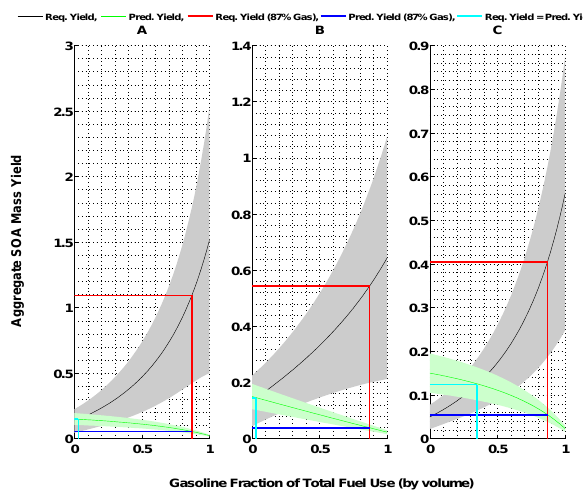
Gasoline Fraction of Total Fuel Use (by volume) Fig. 3. Vehicular SOA mass yields compared to ambient SV-OOA mass yields assuming all fossil SV-OOA is attributable to vehicular emissions. (A) Black line: aggregate SOA mass yield required to match observations at the Pasadena ground site assuming all fossil SOA is attributable to vehicular emissions. Green line: SOA mass yield of unburned fuel (gasoline/diesel) components reported by Gentner et al. (2012). Red line: yield required for 87% gasoline and 13% diesel fuel (state-average). Blue line: SOA mass yield of liq- uid fuel for 87% gasoline and 13% diesel fuel (state-average). Cyan line: point at which the black line crosses the green line. (B) Same as (A) except EF GPOM , gas have been increased by a factor of 2.35. (C) Same as (A) except EF GPOM , gas and EF GPOM , dies have both been increased by a factor of 2.7 (McDonald et al., 2013). Error bars correspond to propagated uncertainties, and all plots have been ad- justed to account for partial reaction of hydrocarbons at 0.45 days of photochemical aging. Required yields are based on SV-OOA mea- surements and 14 C measurements reported in Zotter et al. (2014); Hayes et al. (2013). All quantities are plotted as functions of gaso- line and diesel fuel sales (by